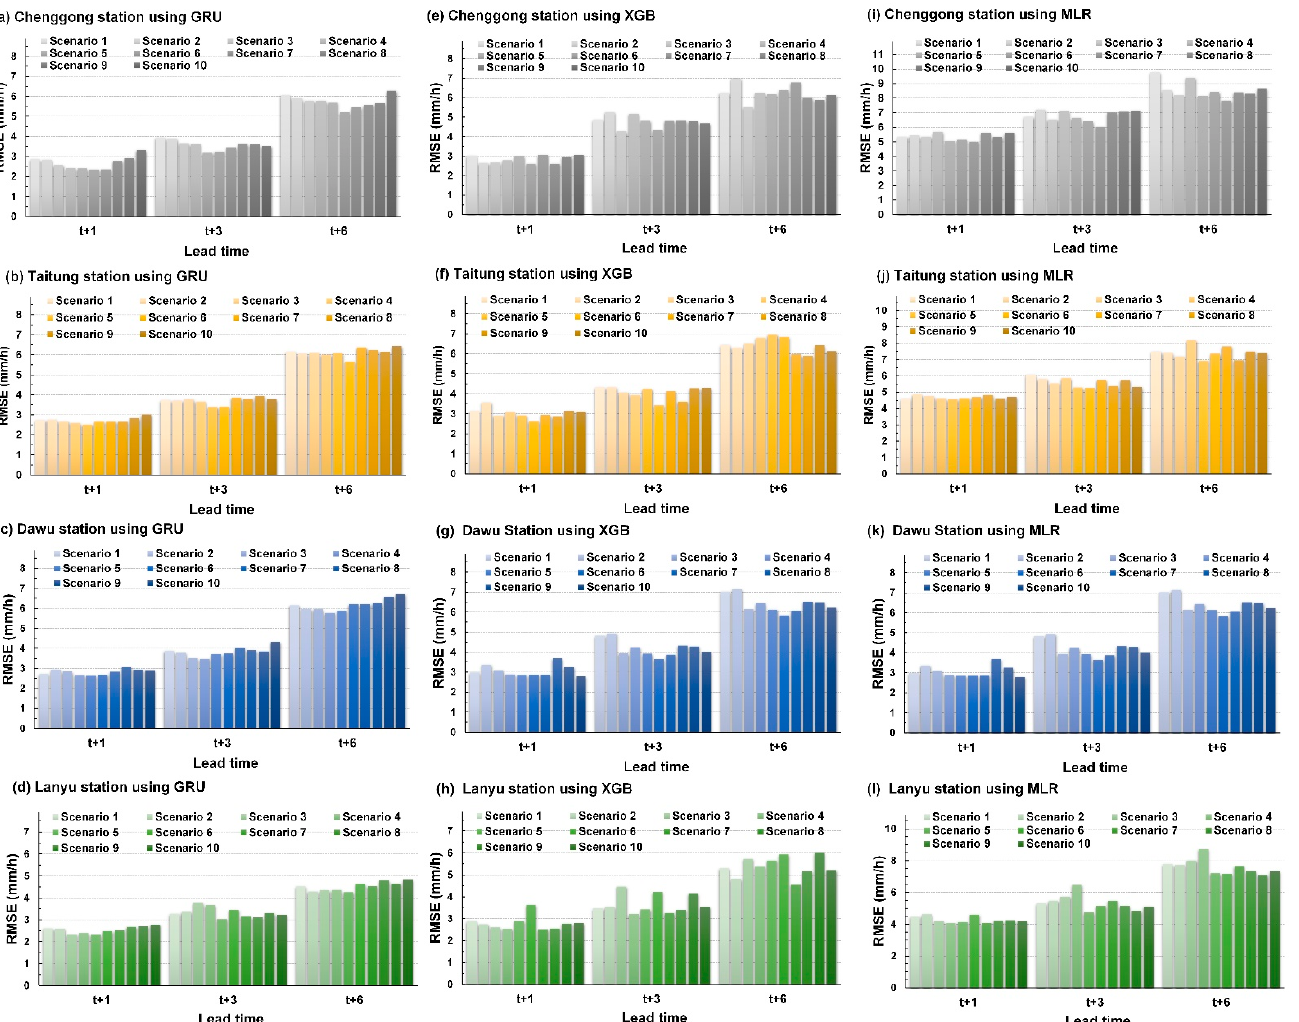
Figure 6. RMSE indices of the forecasting models for each station: ( a – d ) GRU for Chenggong, Taitung, Dawu, and Lanyu stations; ( e – h ) XGB for Chenggong, Taitung, Dawu, and Lanyu stations; ( i – l ) MLR for Chenggong, Taitung, Dawu, and Lanyu stations.